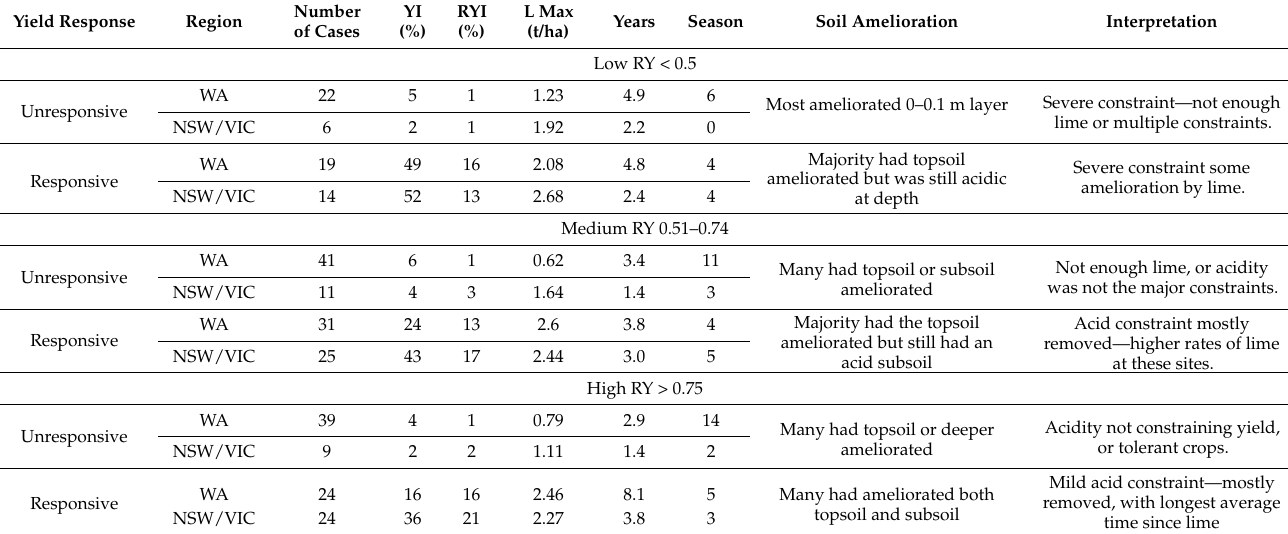
Table 3. Number of cases and increase in yield (%YI, %RY and L Max) with lime application from field trials from WA or NSW/VIC defined by relative yield of unlimed treatments as low (<0.5), medium (0.5–0.74) or high (>0.75)) yield potential and whether they were responsive to lime